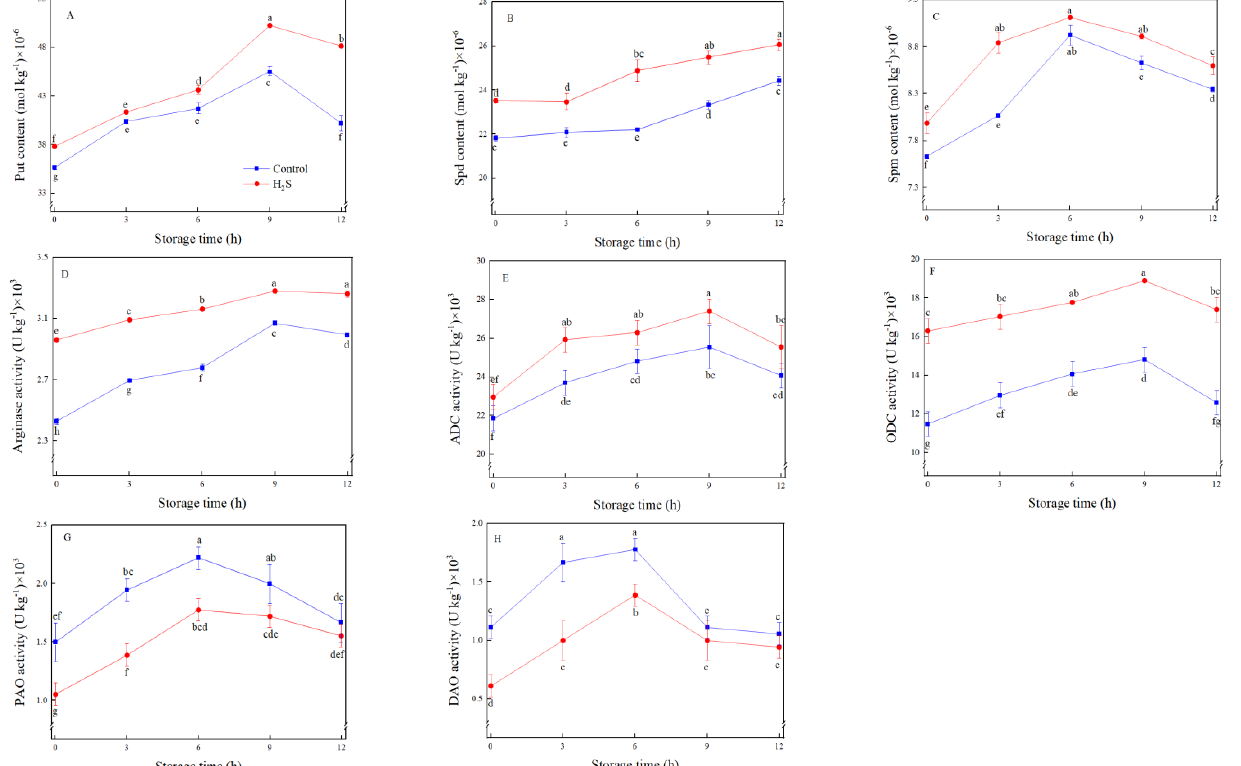
Figure 5. Effects of H 2 S treatment on the content of Put ( A ), Spd ( B ), and Spm ( C ), and the activities of arginase ( D ), ADC ( E ), ODC ( F ), PAO ( G ), and DAO ( H ) of fresh-cut peaches during storage. Data are presented as mean ± standard errors of triplicate samples. Different letters indicate statistically significant ( p < 0.05) differences.